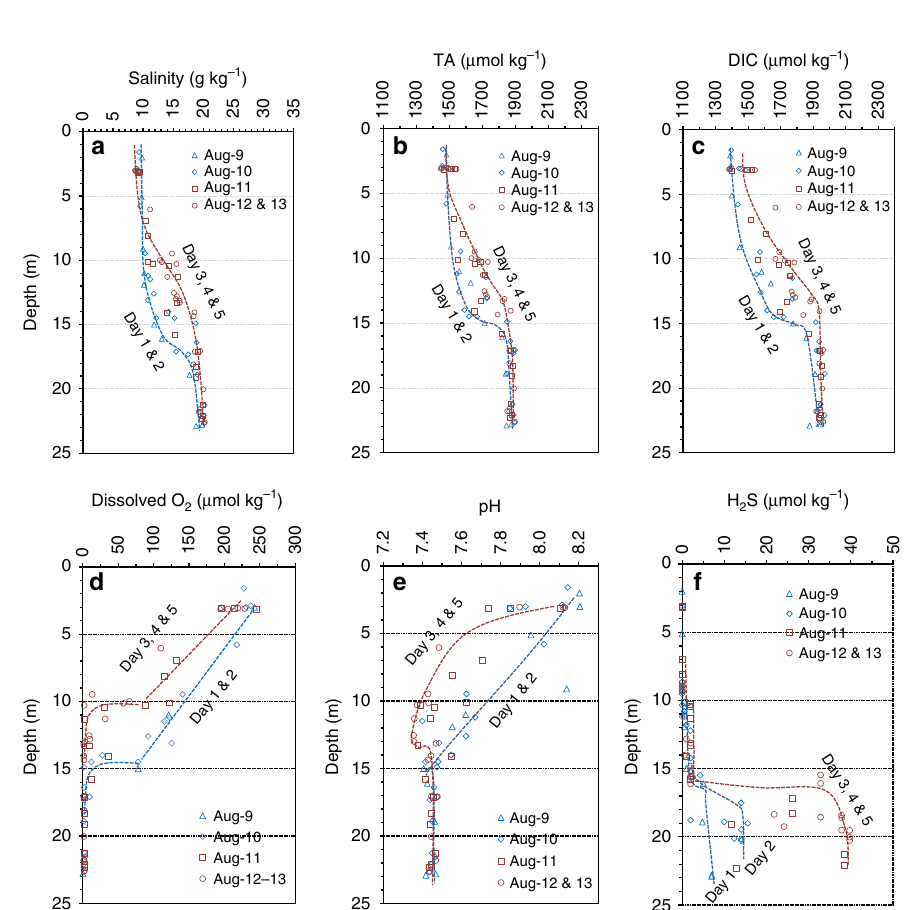
Fig. 2 Vertical distributions of measured chemical properties at the focused study site in August 2013. a Salinity, b total alkalinity ( TA ), c dissolved inorganic carbon ( DIC ), d dissolved oxygen, e pH (25 °C and NBS scale), and f H 2 S concentration. See Fig. 1 for location (station 858). The lines are the lower and upper boundaries between days 1 and 2 and days 3 – 5, respectively. August 2014 data are presented in Supplementary Fig. 8 for comparison and af fi rmation of the 2013